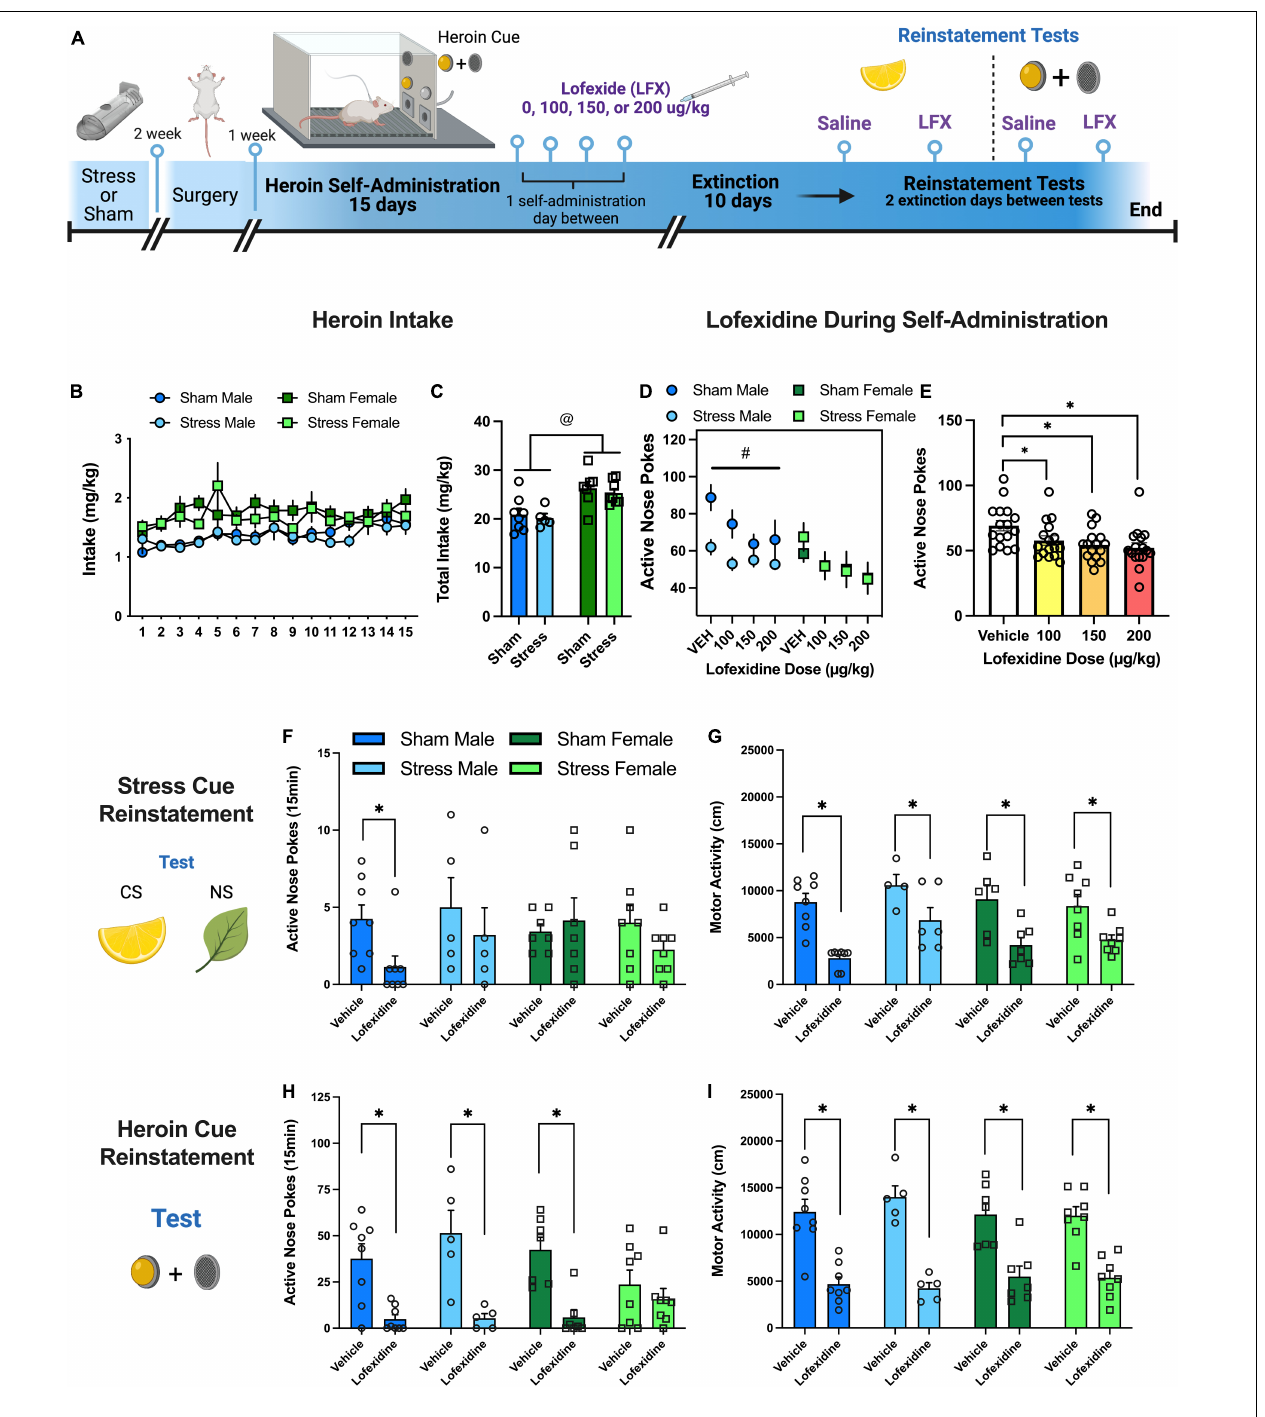
FIGURE 3 | Experiment 3: effects of lofexidine on heroin taking, seeking, and motor activity. (A) Experiment 3 timeline. (B) Heroin intake (mg/kg) over 15 self-administration sessions. Intake increased over sessions and females had higher intake than males. (C) Total heroin intake (mg/kg) over 15 sessions. Both sham and stress females had higher total intake than sham and stress males. (D) Active nose pokes during heroin self-administration with vehicle or varying doses of lofexidine (100, 150, 200 µ g/kg). All doses of lofexidine decreased active nose pokes relative to vehicle regardless of sex or stress, so data were collapsed (see Figure 3E ). (E) Lofexidine decreased active nose pokes regardless of dose. Active nose pokes (F) and motor activity (G) during 15 min stress CS reinstatement tests with vehicle or lofexidine. Lofexidine decreased active nose pokes relative to vehicle in sham. Lofexidine also decreased locomotor activity regardless of stress group or sex. Active nose pokes (H) and motor activity (I) during 15 min heroin cue reinstatement tests. Active nose poke responding resulted in an interaction between stress, sex, and lofexidine treatment. Lofexidine decreased active nose pokes in both sham and stress males and sham females. Lofexidine decreased locomotor activity regardless of stress or sex. Data are represented as group means ± SEM with individual values. @ indicates significant sex difference, p < 0.05. # indicates significant difference between stress and sham males, p < 0.05. * indicates significant difference from vehicle, p < 0.05.